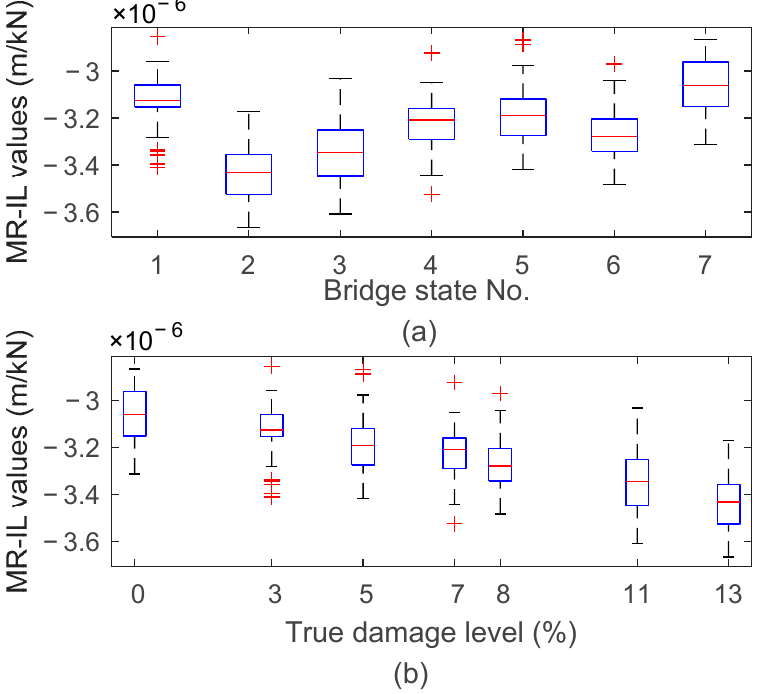
Figure 12. Box plot of mid-span fundamental MR-IL values of carriage model for Profile 1, organised by ( a ) bridge state number and ( b ) damage